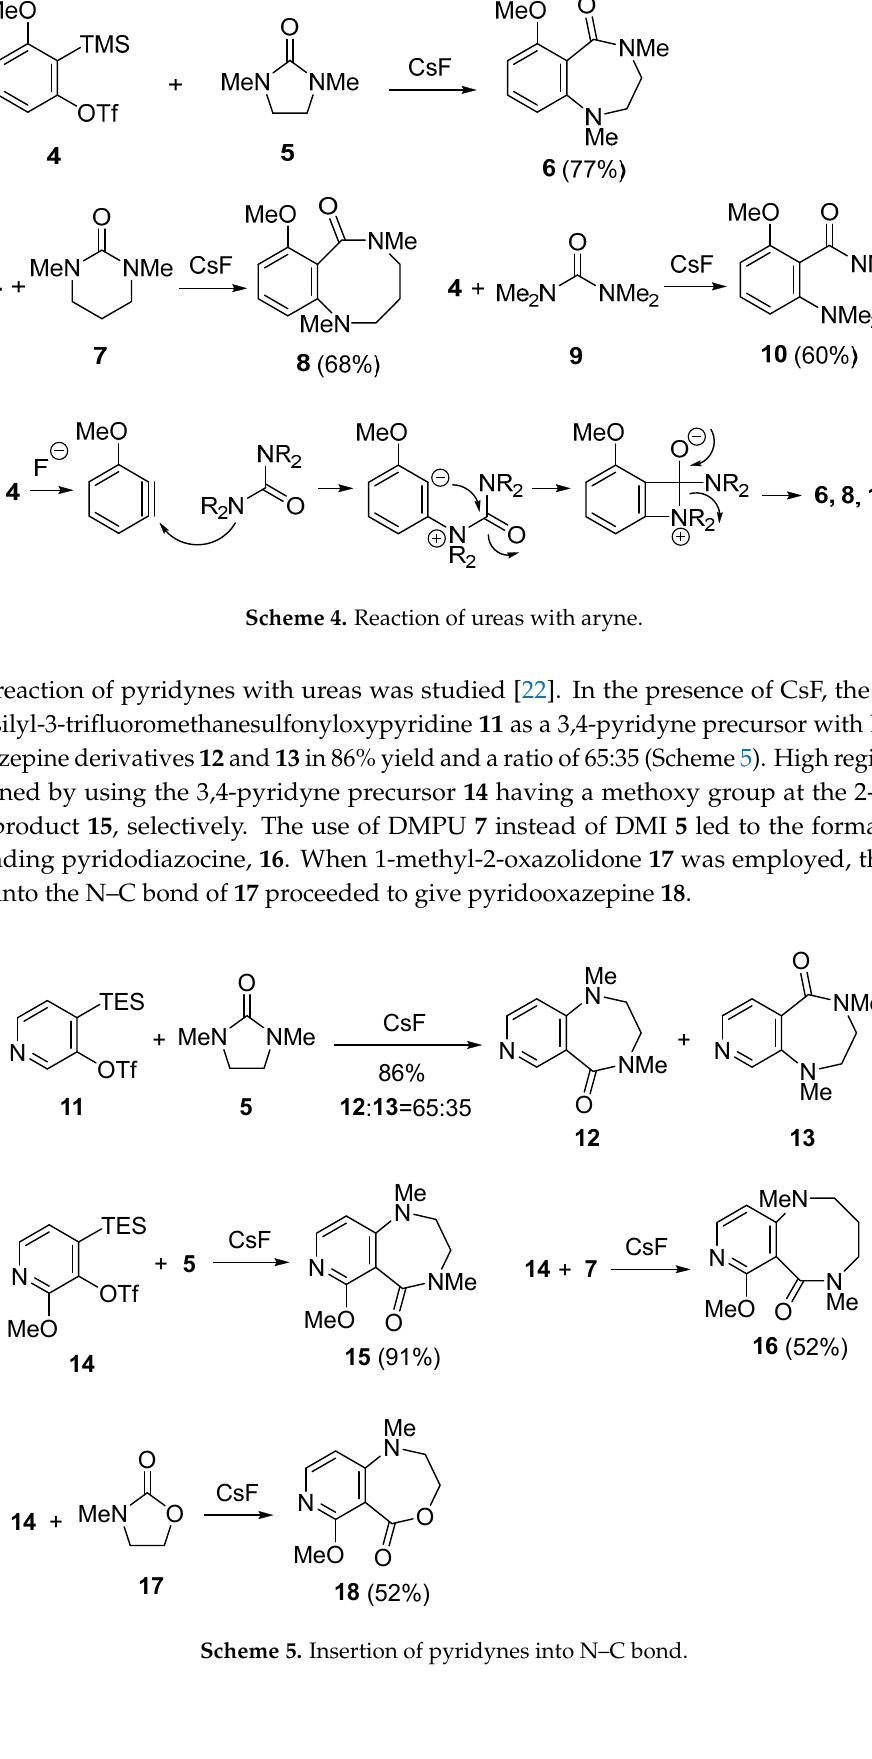
Scheme 5. Insertion of pyridynes into N–C bond.